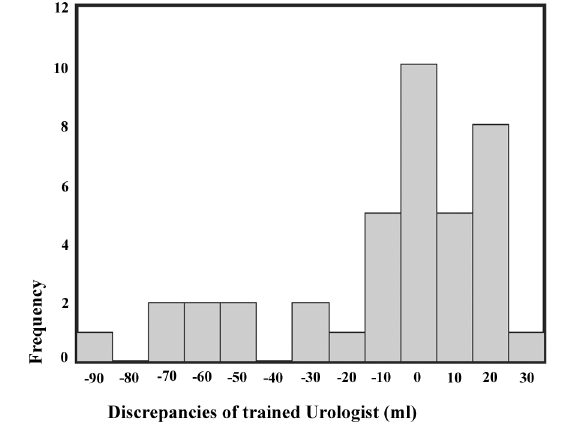
Figure 6 – Frequency distribution of discrepancies for trained